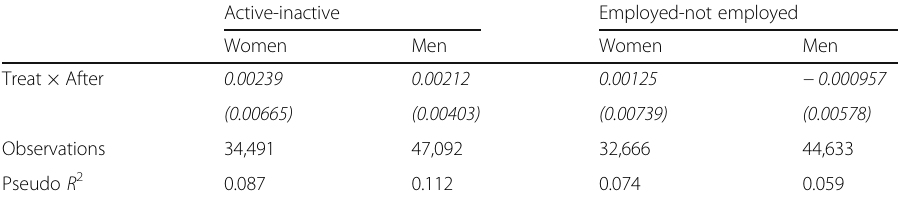
Table 11 Effect of AUH on the probability of exiting the labor force. Active-inactive, employed-not employed Active-inactive Employed-not employed Treat × After